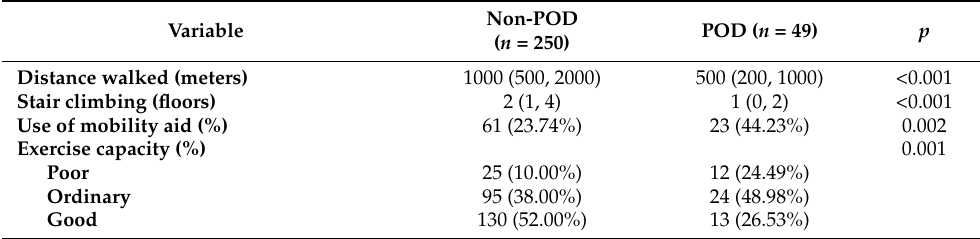
Table 5. Per-injury self-reported physical performance *.